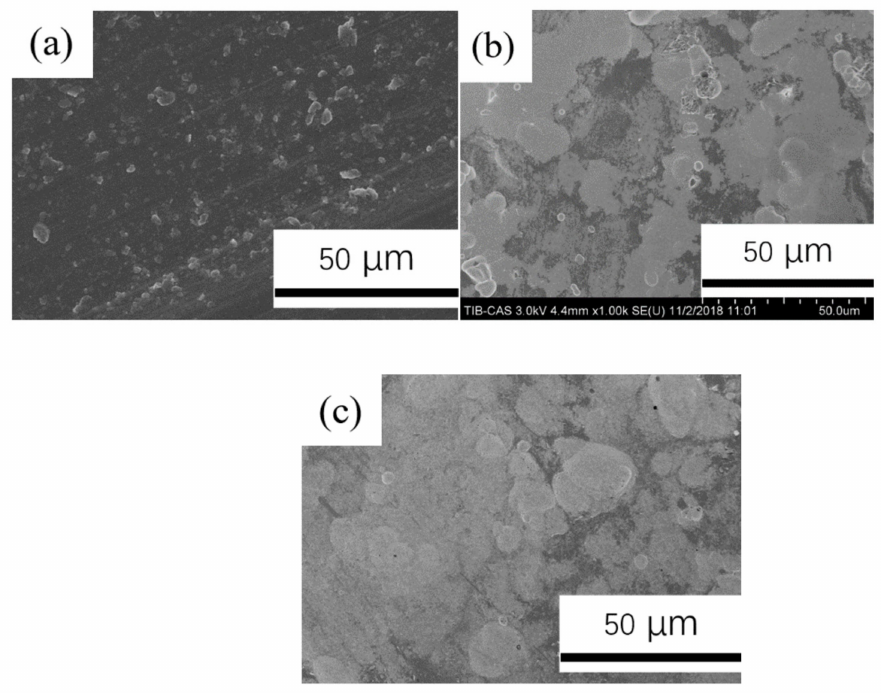
Figure 15. SEM images of un-anodized aluminum alloys: ( a ) 1060, ( b ) 2024 and ( c ) 7075. With the extension of the anodic oxidation time; the increase in the anodic oxidation temperature, electrolyte concentration and anodic oxidation voltage; and the speeding of the anodic oxidation process, the non-porous areas on the surface are dissolved and the pores become more regular and uniform. By exceeding the optimized anodic oxidation parameters, the porous anodic Al 2 O 3 structure is destroyed and the pores gradually disappear, along with cracked pore